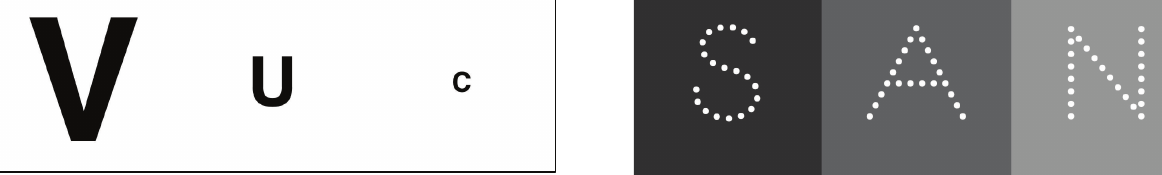
Figure 2: An example of the algorithmically generated letter triplet for testing CS. CS: contrast